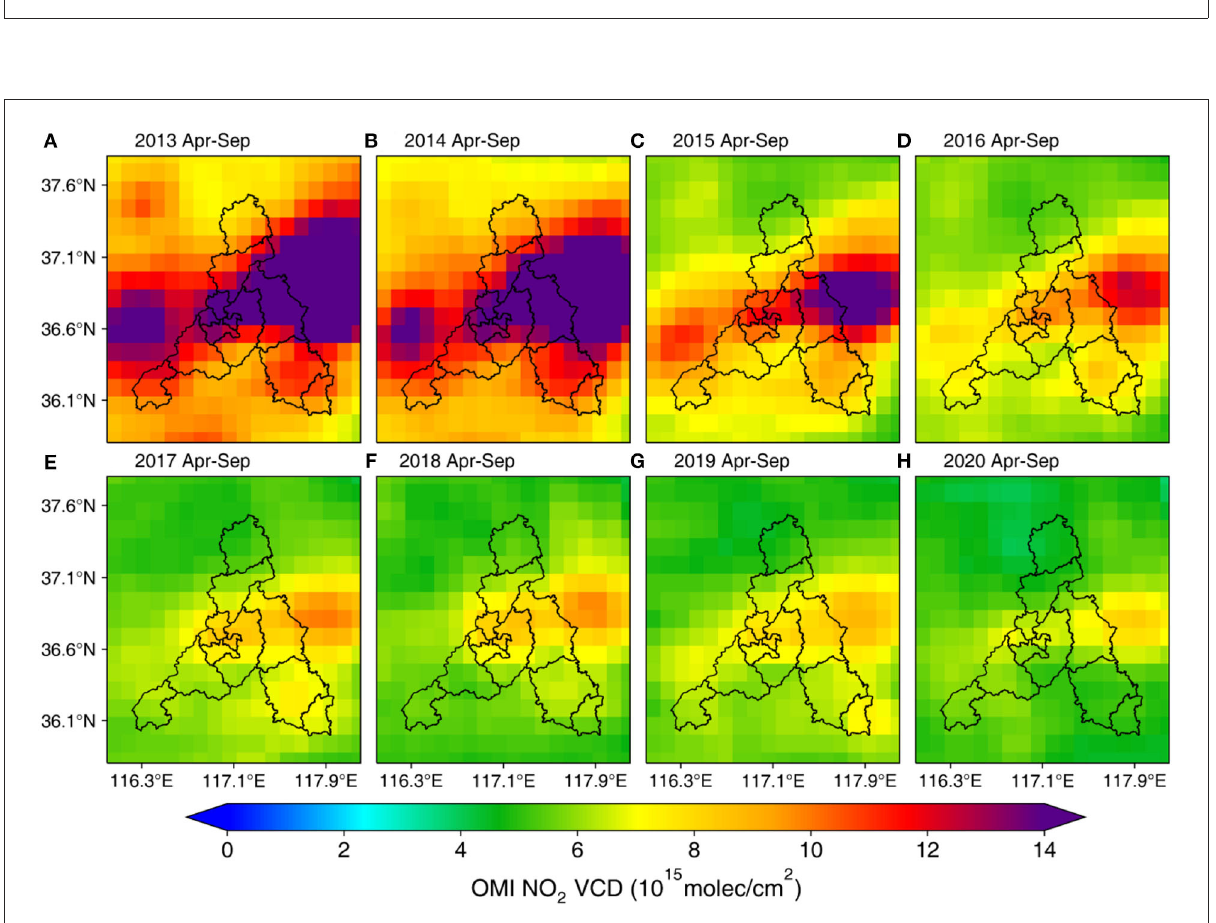
FIGURE4 OMI mean tropospheric NO 2 vertical column density (VCD) during warm season (April–September) from 2013 to 2020 over Jinan